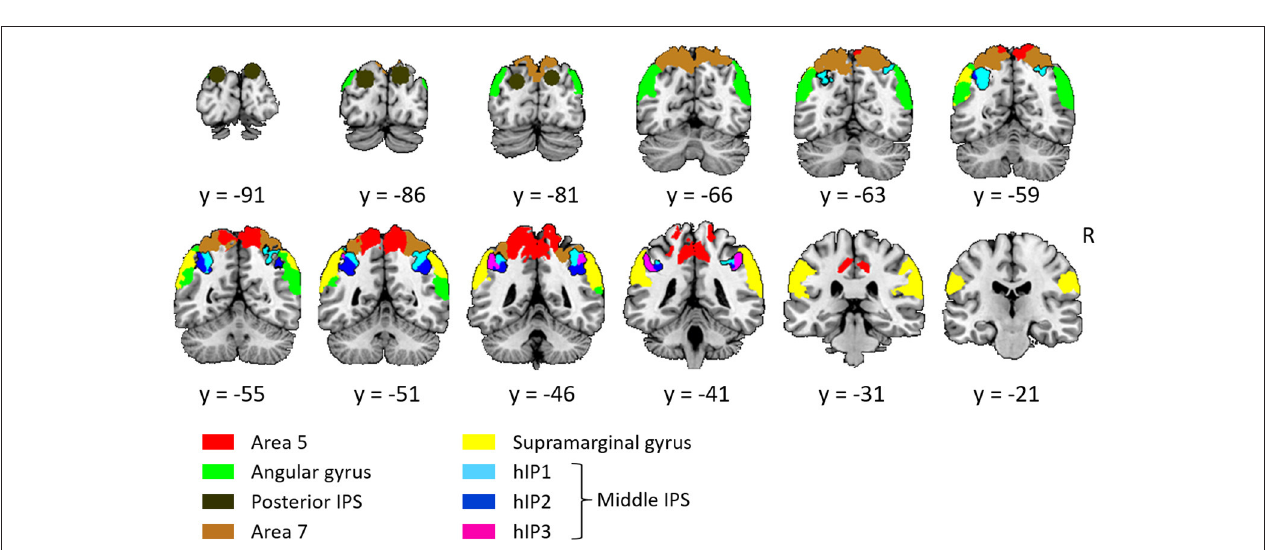
MNI peak coordinates (left: 33, 57, 48; right: 42, 42, 48) and the overlap between these VOIs and the individuals’ gray matter was used for multivariate pattern analysis